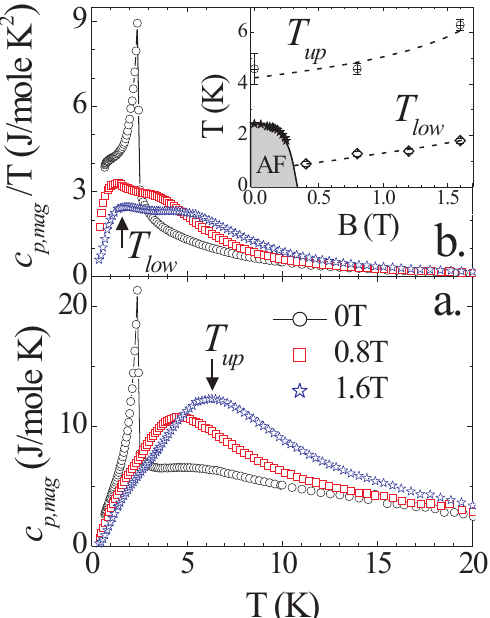
Figure 3. ( a ) Field dependence of c p , mag of MnNi(NO 2 ) 4 (en) 2 for fields B (cid:107) c . ( b ) The same data plotted as c p , mag / T . Inset: The magnetic phase diagram of MnNi(NO 2 ) 4 (en) 2 for B (cid:107) c : T N from Ref. [47] ( (cid:63) ), T up from the maximum in c p , mag ( ⊕ ), T low from the maximum in c p , mag / T ( (cid:5) ); lines are guides to the